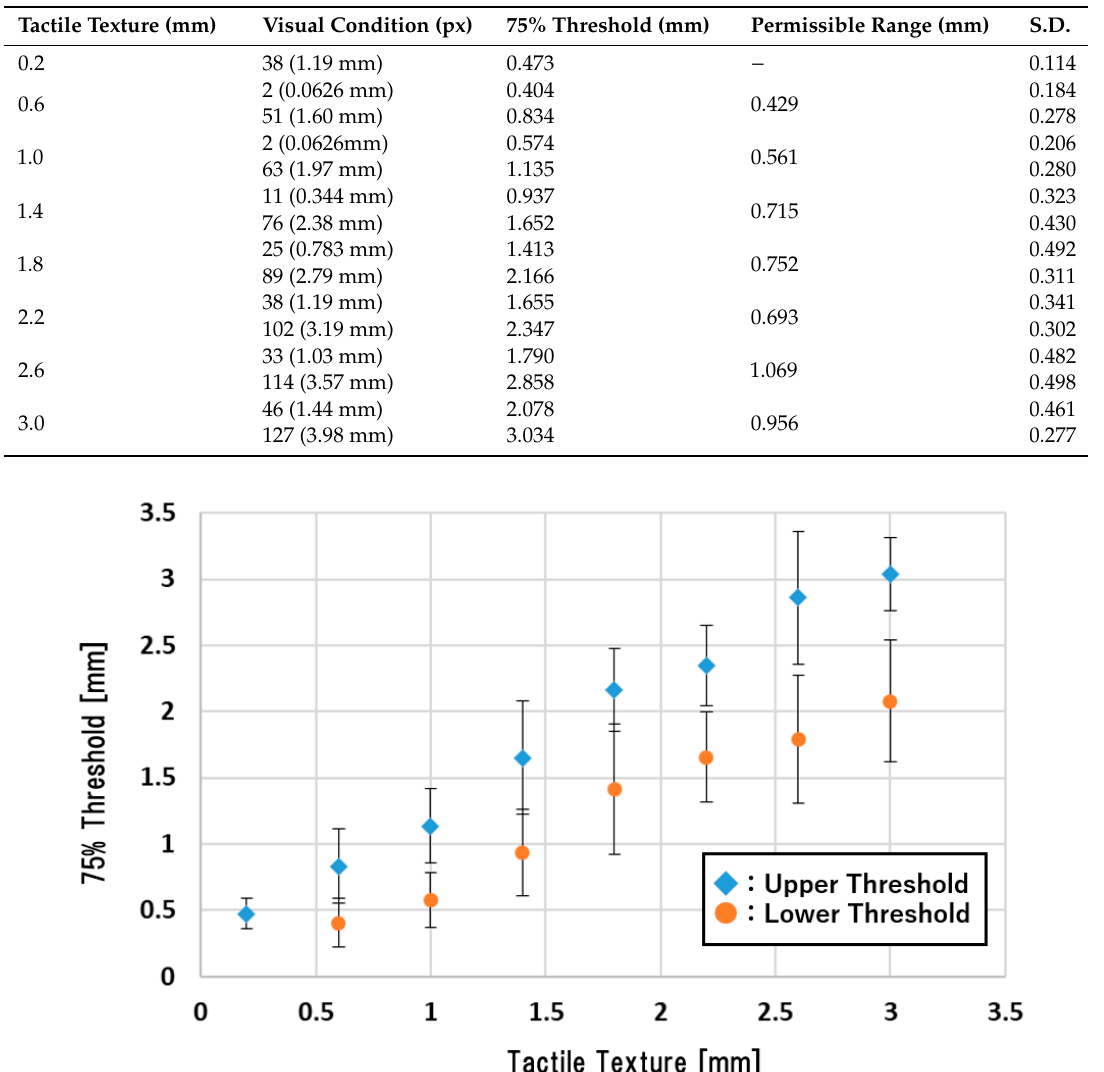
Table 1. Results of the experiment. The permissible range is the di ff erence between upper threshold and lower threshold.